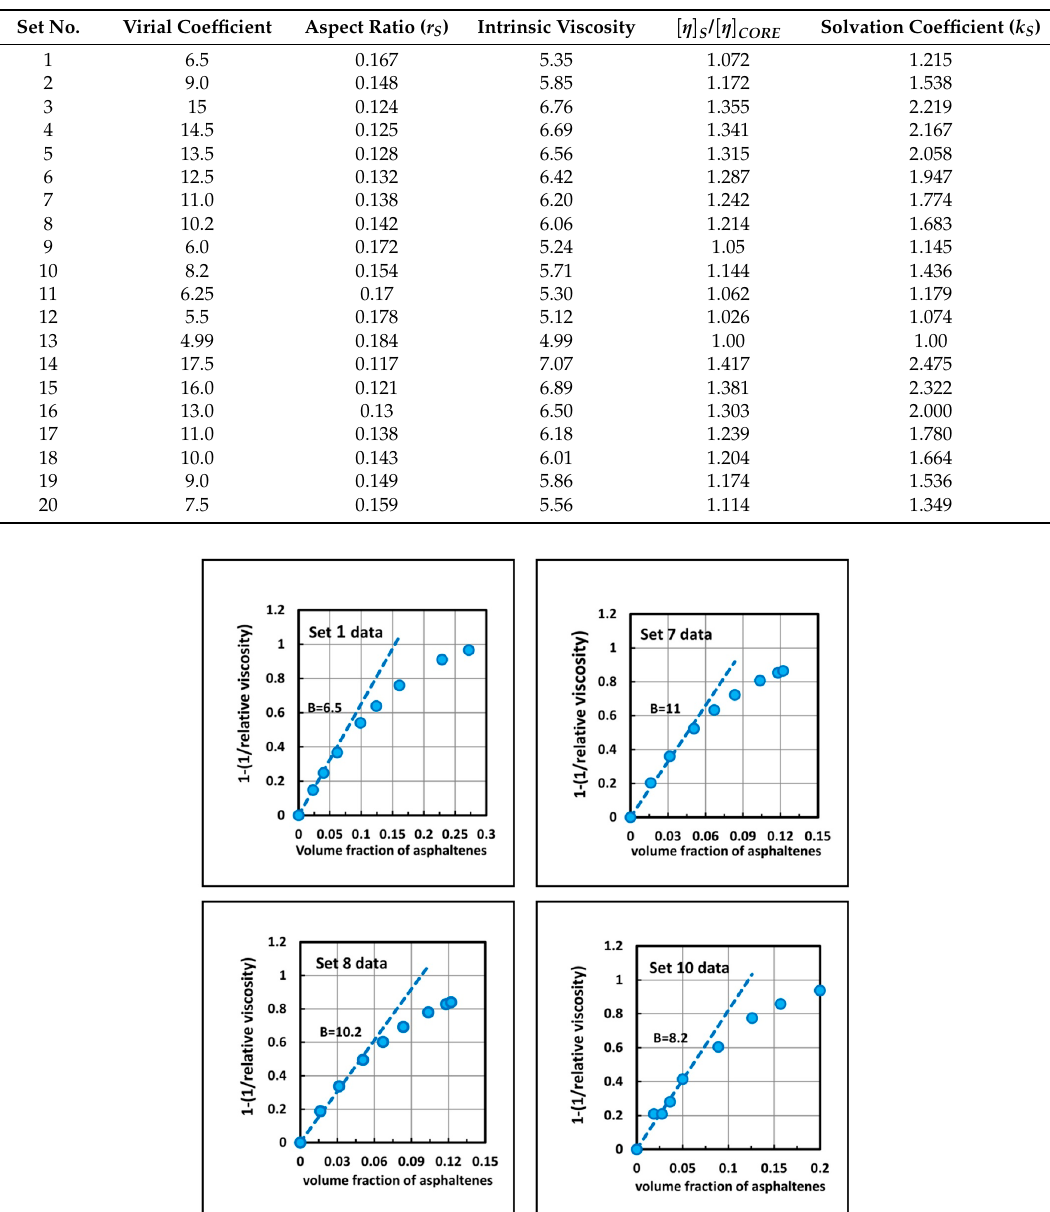
/ [ η ] and solvation S CORE